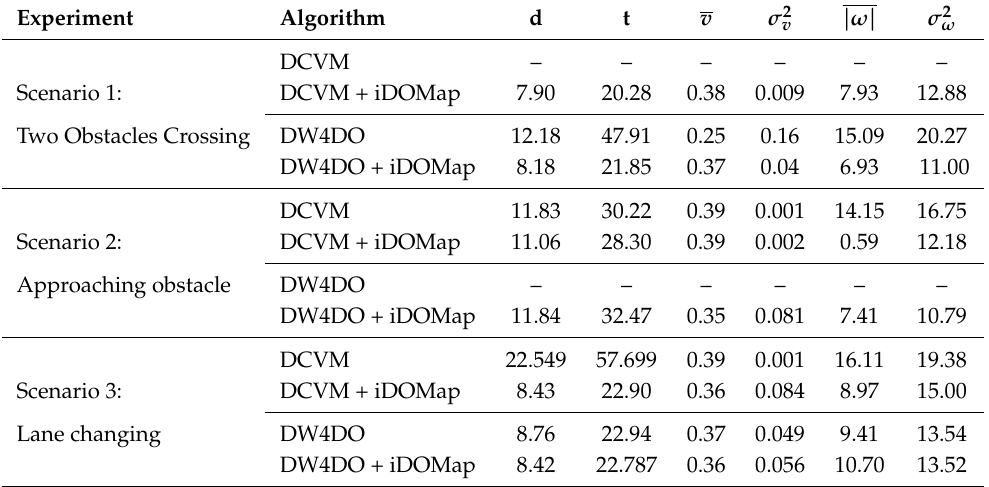
Table 7. The parameters shown in Table 7 measure velocity of the maneuver: distance travelled d (m) and time spent t (s) to reach the goal, also the medium linear velocity v (m/s), while others